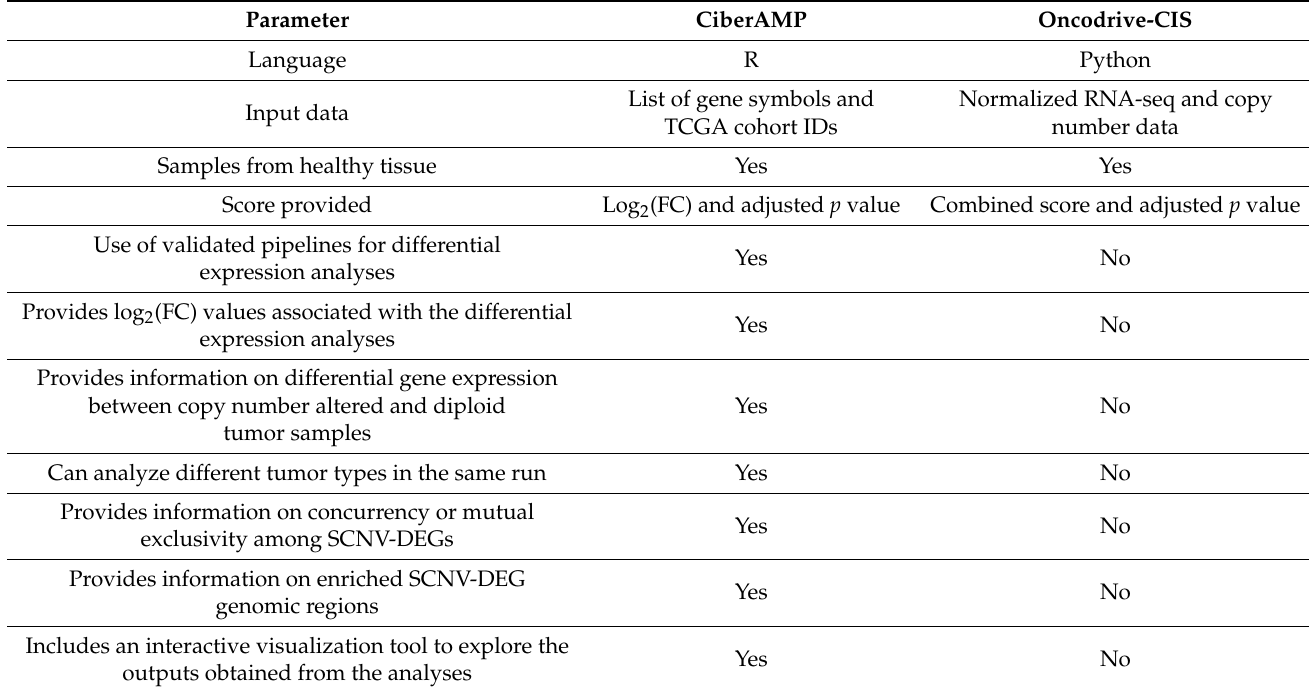
Table 1. Comparison between the main features of CiberAMP and